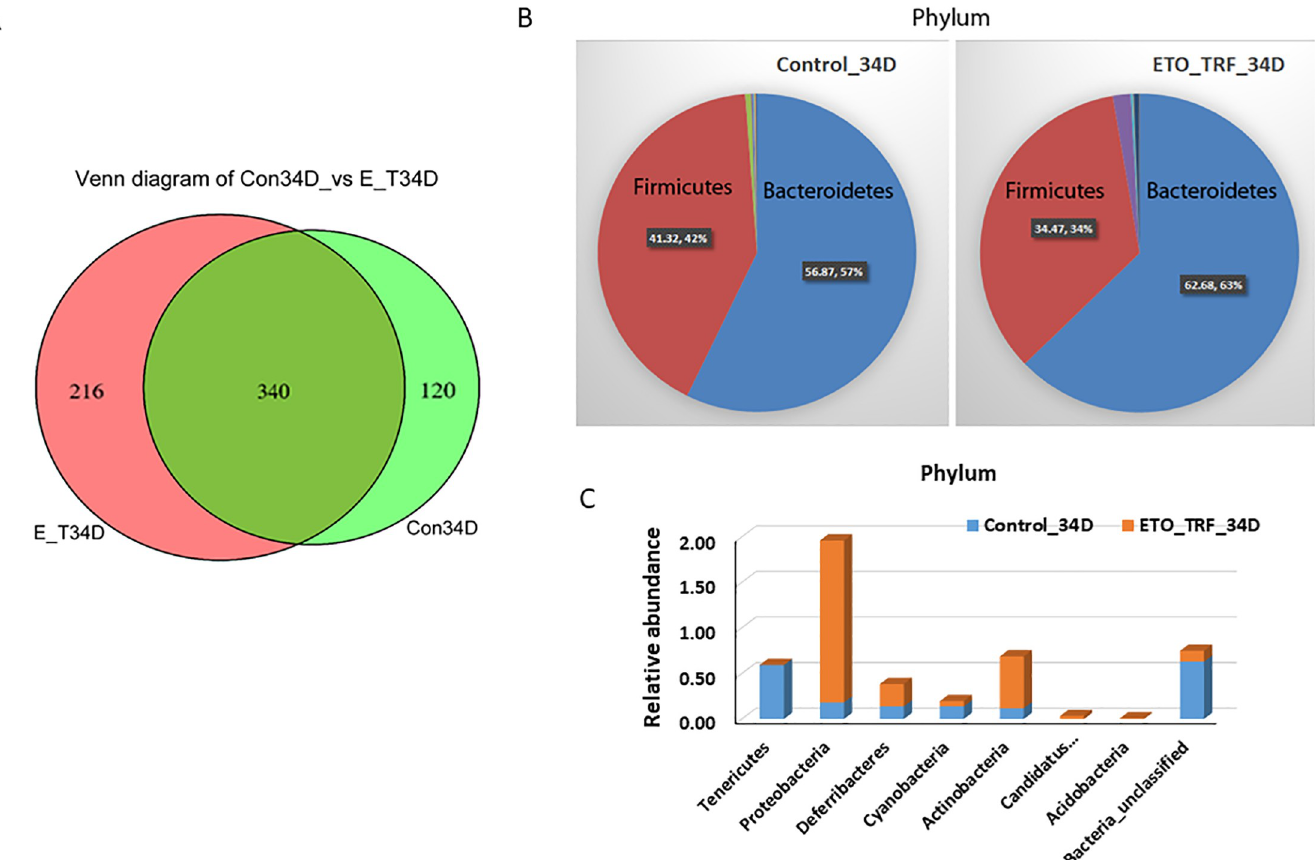
Fig 3. Venn diagram showing shared microbial OTUs between 34 day of ETO-Cur-TRF treated and control mice; ETO-Cur-TRF increased microbial diversity (A) and altered microbial phylum (B and C). Genomic DNA from mouse fecal cells was isolated using QIAamp DNA Stool Mini Kit (Qiagen) according to the manufacturer’s instruction, subsequently used for analysis of 16S rRNA gene community